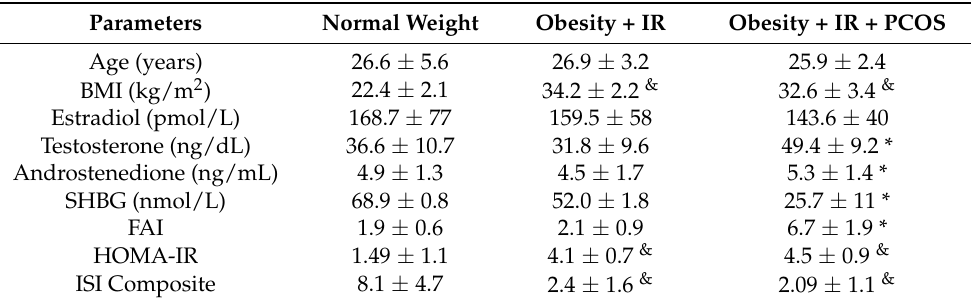
Table 1. Clinical characteristics of study